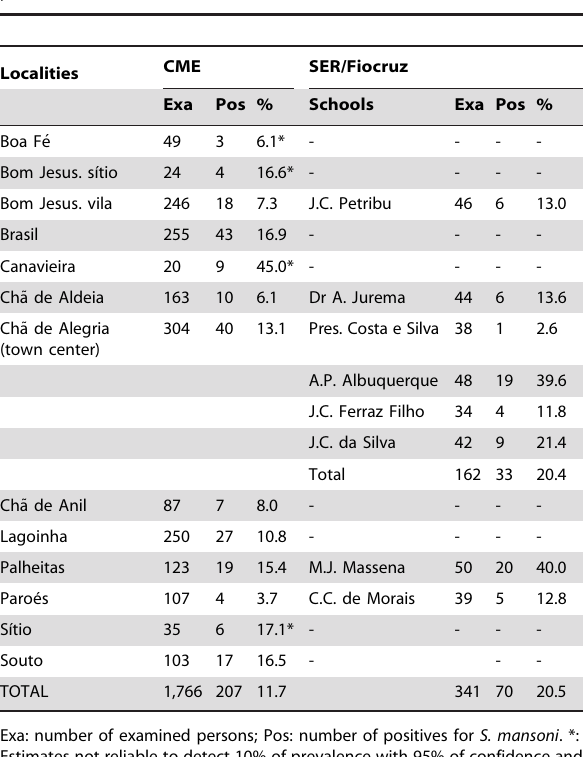
Table 4. Status of infection by S. mansoni among school- children (7–14 yrs) examined both at the population survey carried by the Municipal Coordination of Endemic Diseases Diseases (CME) of Cha˜ de Alegria in 2003–2004 and in the school survey by the Schistosomiasis Reference Service of Oswaldo Cruz Foundation (SRE/Fiocruz) one year